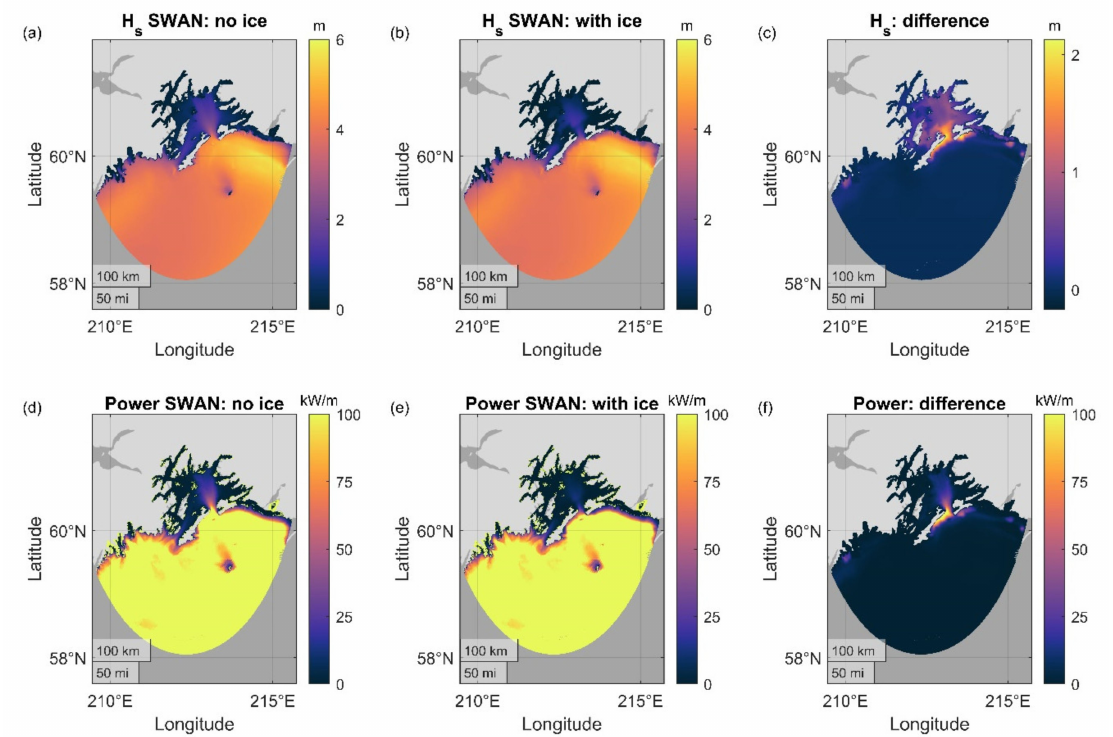
Figure 10. Comparisons of significant wave height, H s , and power in model output of 7 December 2017, when significant sea ice was present, as shown in Figure 3b. ( a ) H s as calculated by SWAN run without ice; ( b ) H s as calculated by SWAN run with ice; ( c ) H s difference between the SWAN runs with and without ice; ( d ) power from SWAN run without ice; ( e ) power from SWAN run with ice; and ( f ) power difference between SWAN runs with and without